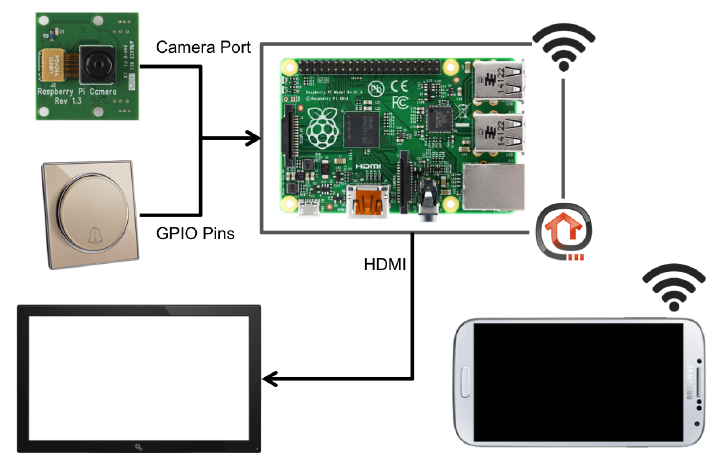
Figure 12. The hardware supporting the generated “Who is?”